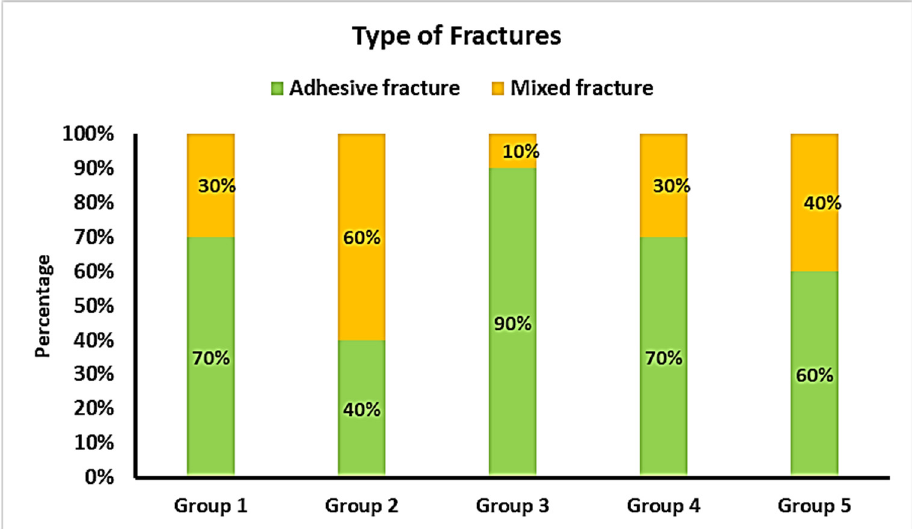
Figure 5. Distribution of the types of fractures in the different groups.